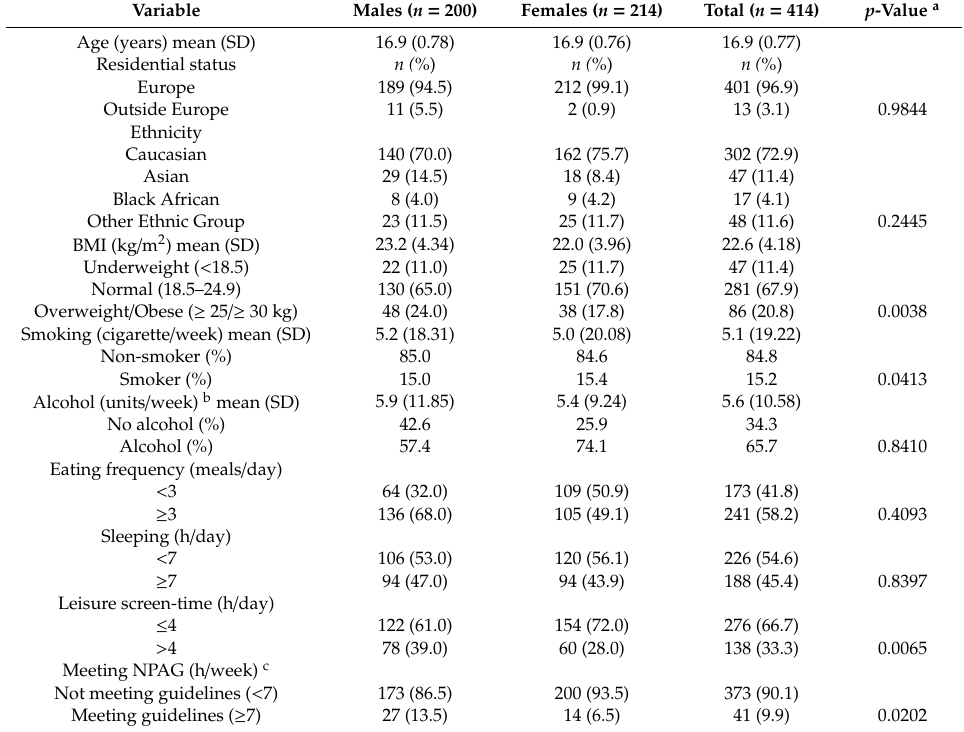
Table 1. Demographics and health-related lifestyle behaviours by